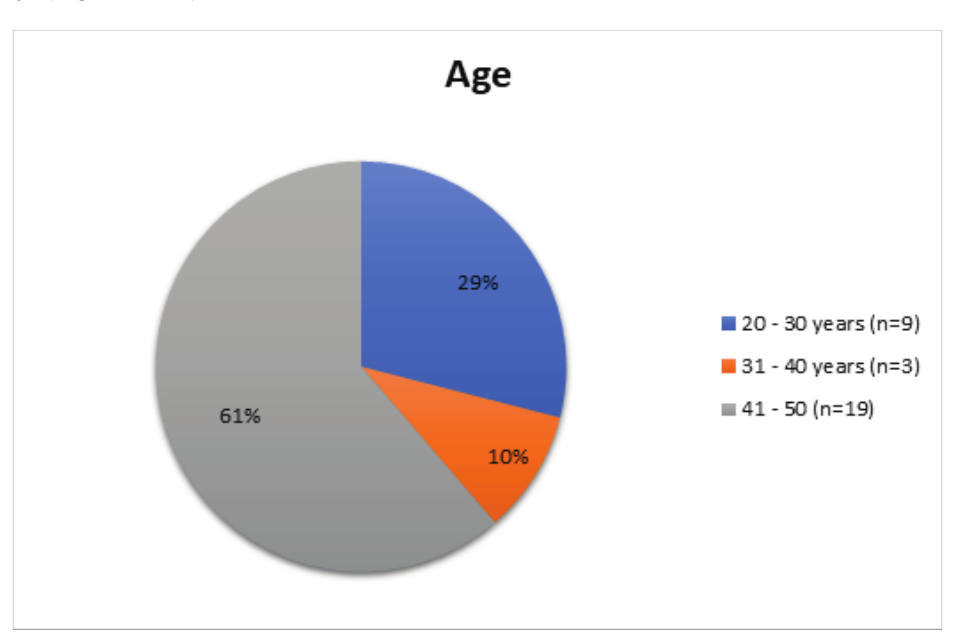
Figure 1: Age distribution among PINK1 early onset PD patients ( n = 31).